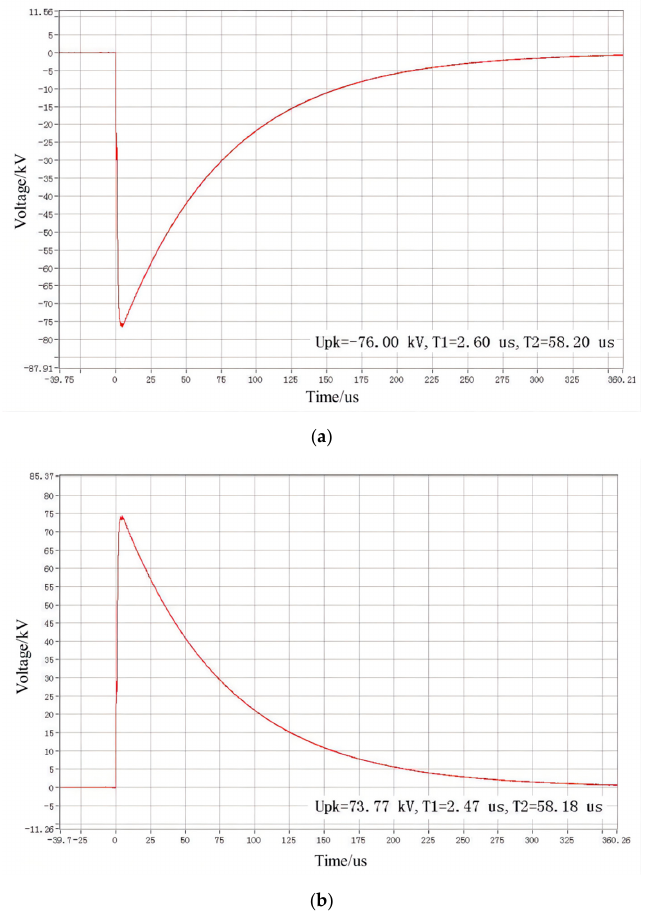
Figure 14. Lightning impulse voltage test: ( a ) negative ( − 75 kV ); ( b ) positive ( +75 kV ).